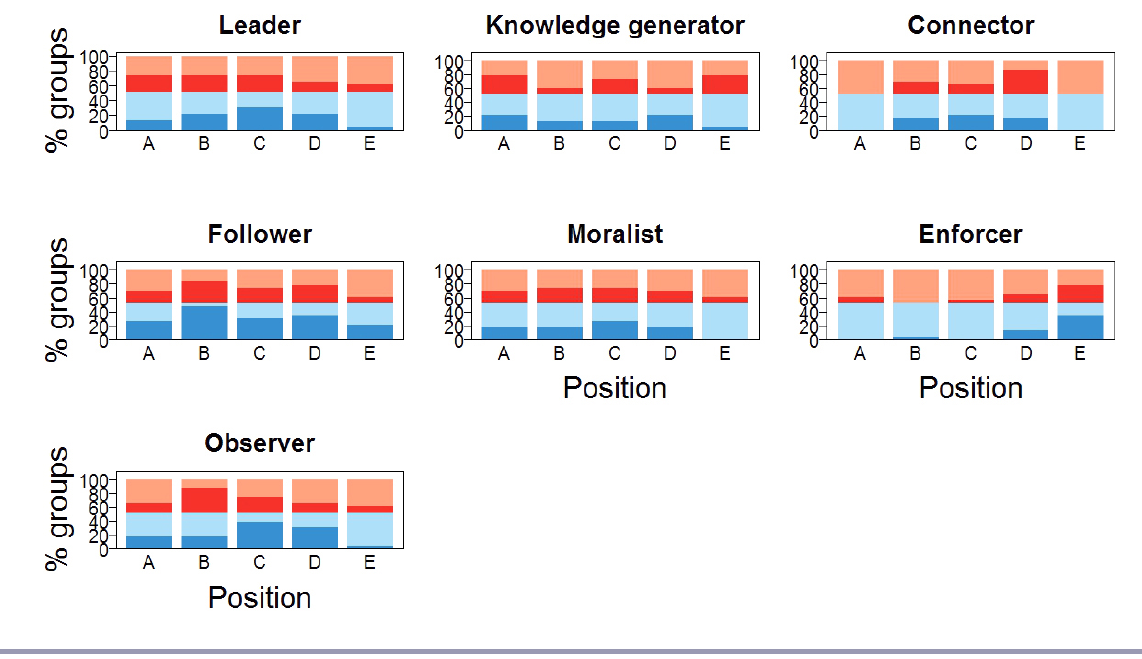
Fig. 6 . Distribution of the presence/absence of each role per position when the data shown in Figure 5 are broken down into successful (blue bars in the lower half of the figure) and unsuccessful (red bars in the upper half of the figure) groups. Dark shading means that the role is present; light shading means that the role is absent. Some social roles emerged more frequently in some of the positions.